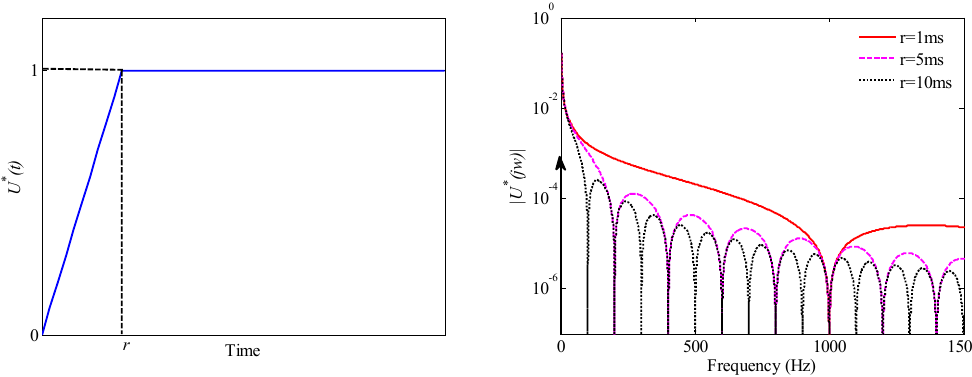
Figure 1. Ramp signal and its amplitude spectrum.